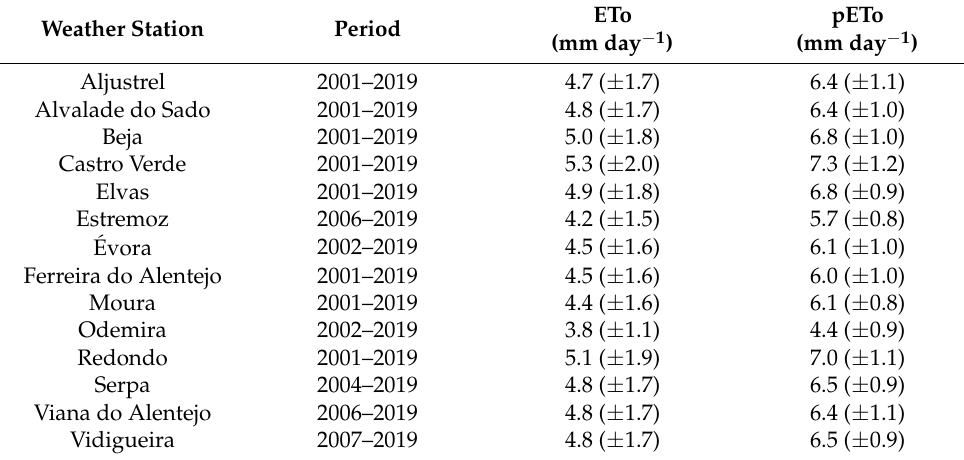
Table 1. Weather stations range of the weather data series and means and standard deviations of reference evapotranspiration (ETo).